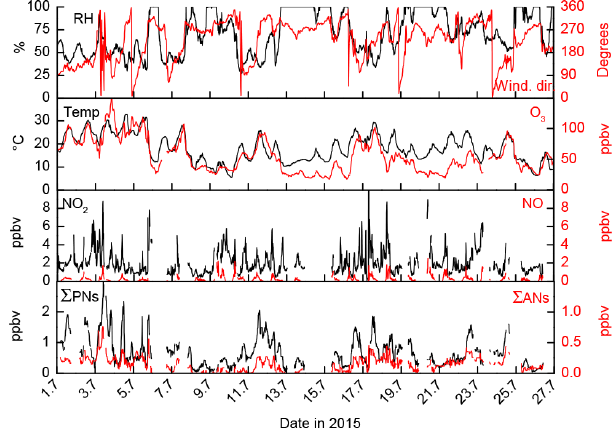
Figure 2. NOTOMO 2015: time series of relative humidity (RH), wind direction, temperature, and the mixing ratios of O 3 , NO 2 , NO, (cid:54) PNs, and (cid:54) ANs. The NO mixing ratios were calculated assuming photostationary state as described in the